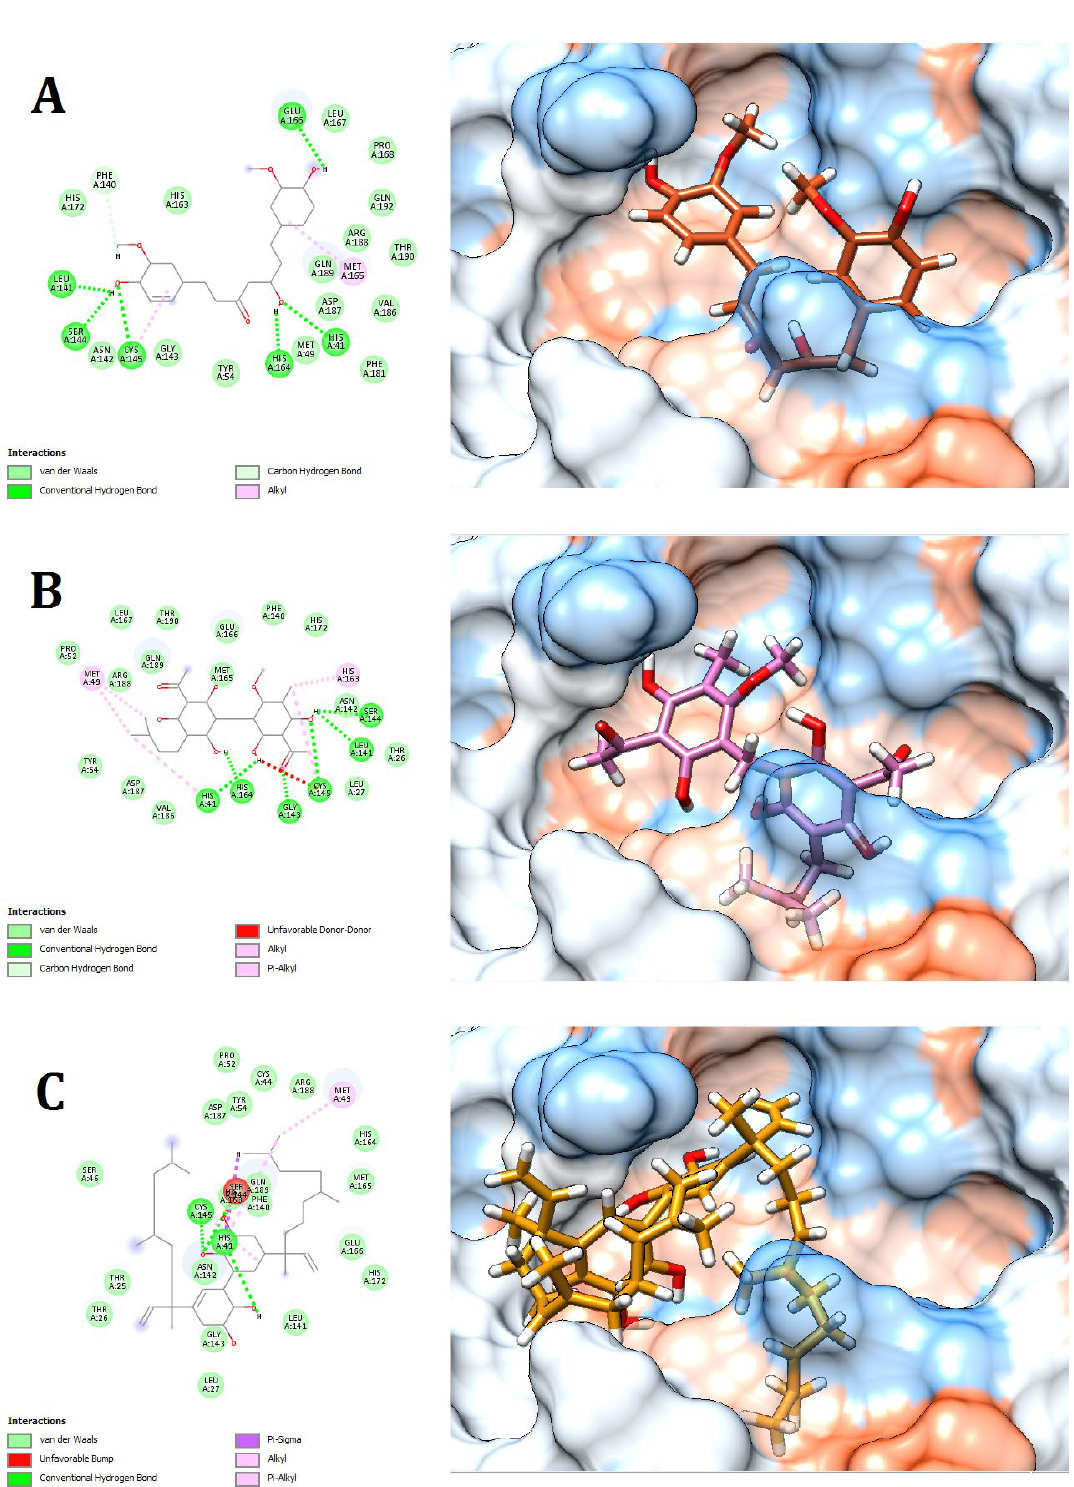
Figure 7. Docking pose visualization for the plant compounds with the best predicted results (Right) and their 2D receptor-ligand interaction diagram